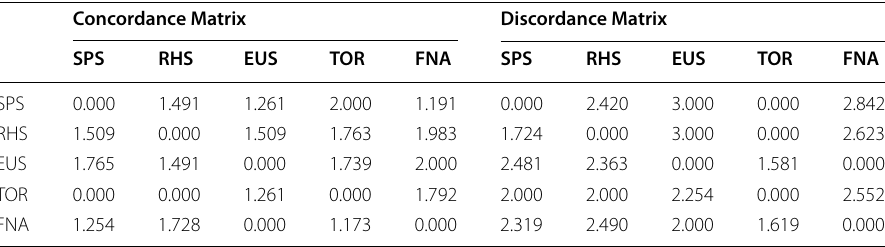
Table 16 Score function of the matrixes for quantum spherical fuzzy sets Concordance